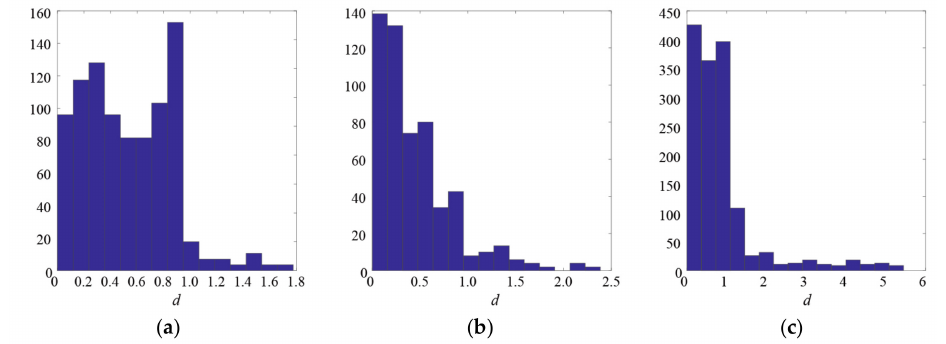
Figure 11. Numerical distribution statistics of three di ff erence degrees d in 50 vehicle models: ( a ) Type-1 di ff erence degree; ( b ) Type-2 di ff erence degree; ( c ) Type-3 di ff erence degree.